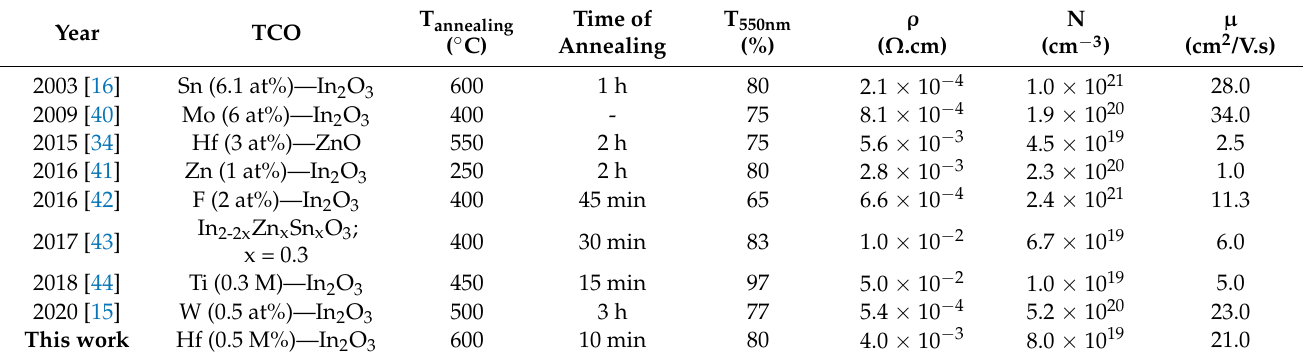
Table 1. Electrical properties of transparent conducting oxides prepared by solution methods.